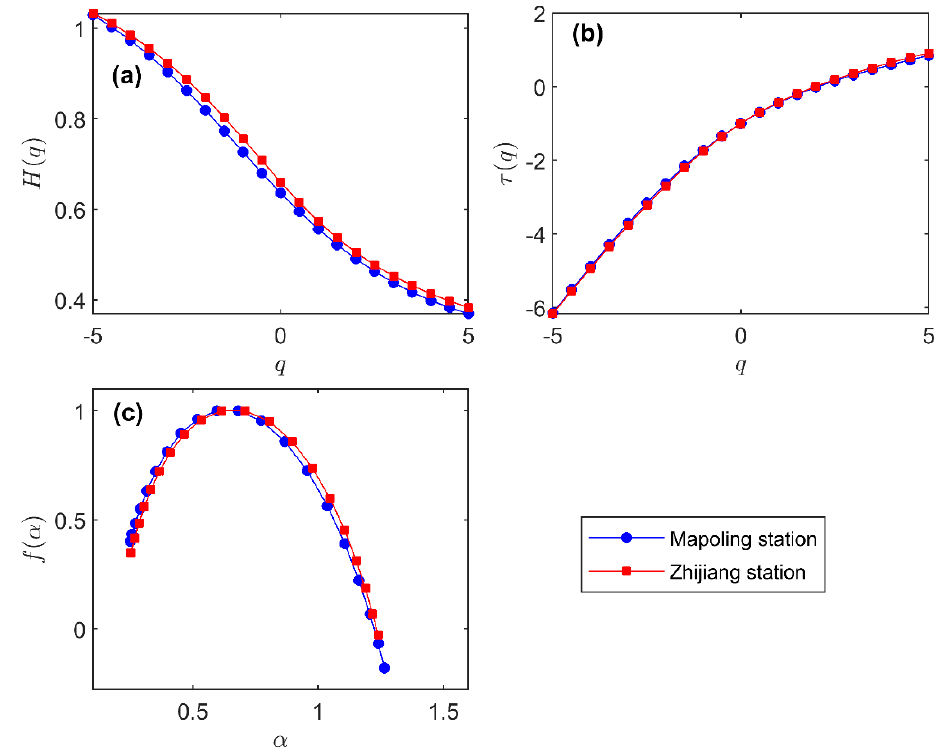
Figure 6. The curves of ( a ) the generalized Hurst exponents H ( q ) and order q ; ( b ) the scaling exponents τ ( q ) and order q ; ( c ) the singularity spectrum f ( α ) and singularity exponents α for the Mapoling and Zhijiang stations.